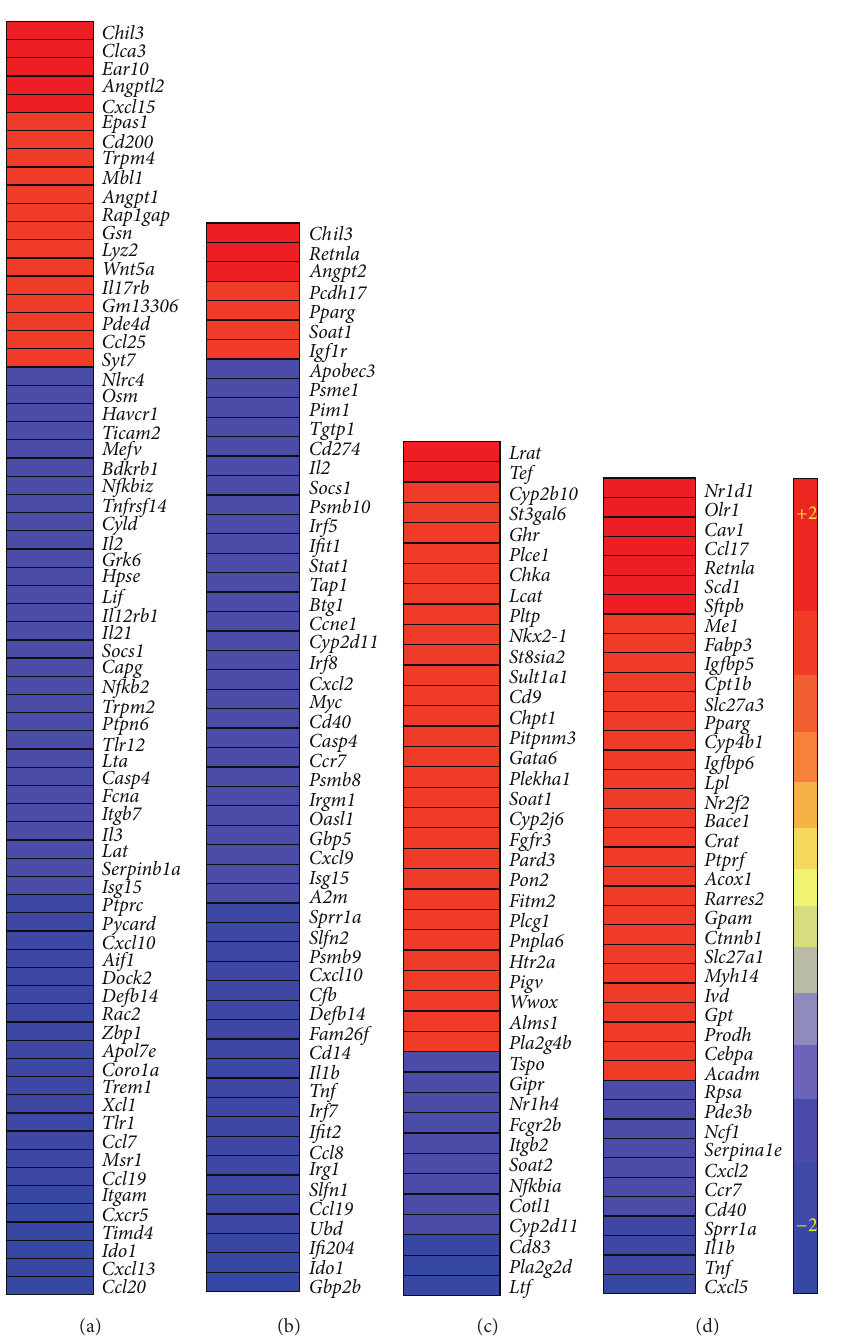
Figure 4: Intensity plot of network genes differentially expressed in the vaccinated and Mtb-infected mice lungs. (a) Intensity plot of significantly differentially expressed genes involved in the inflammatory response network. (b) Intensity plot of significantly differentially expressed genes involved in the STAT-1 regulon network. (c) Intensity plot of significantly differentially expressed genes involved in the PC metabolism network. (d) Intensity plot of significantly differentially expressed genes involved in the PPAR- 𝛾 regulon network. The values plotted in (a)–(d) are different in fold change in the Δ bfrB vaccinated, compared to BCG vaccinated, Mtb-infected mice lungs. Upregulated genes are in red and downregulated genes are in blue. The color scale bar ranges from +2 (red) to − 2